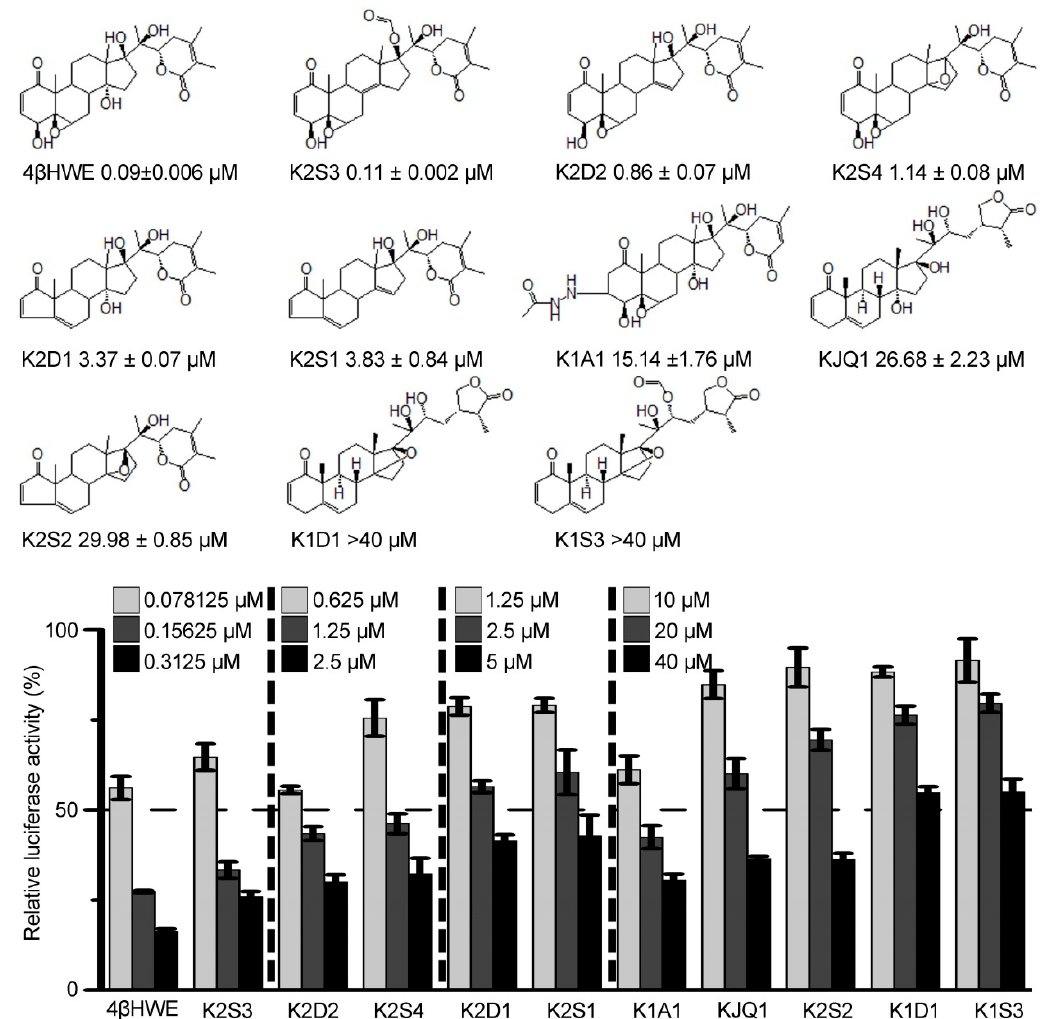
Figure 1. Identification and structure–activity relationship of 4 β HWE as a novel Wnt signaling antagonist. HEK293 cells stably transfected with SuperTopflash luciferase (ST-Luc), Wnt3a, and Renilla cells were incubated with 4 β HWE or its analogs for 24 h. The inhibitory activity of the compounds was analyzed. The values represent the mean ± SD ( n = 3). The half ST-Luc inhibition (IC 50 ) values were calculated, and the data represent the mean ± SD from three independent experiments.